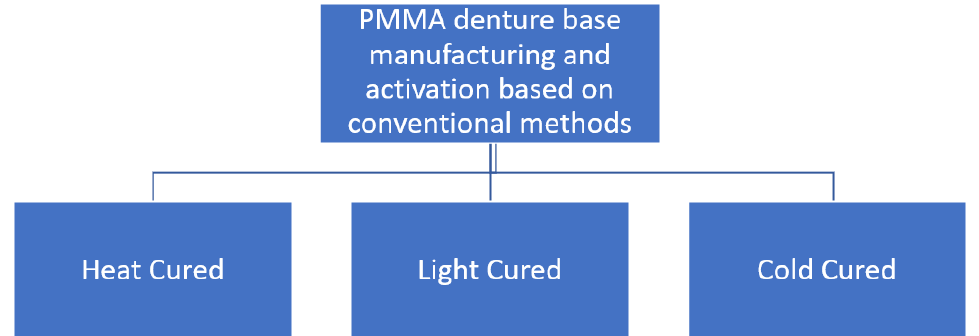
Figure 2. Denture base fabrication conventionally based on PMMA material.